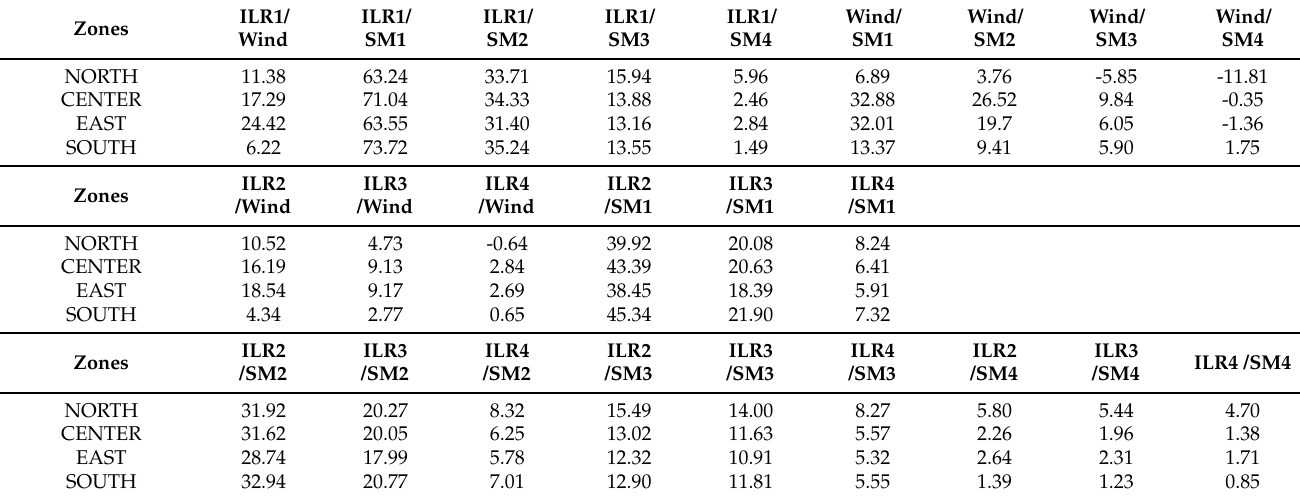
Table A3. Estimates of the covariances (10 − 10 ) between the predicted capacity factors and the inverse of the demand in the same region over the year 2018. ILR1 or SM1: without storage; ILR > 1 or SM > 1: with increasing levels of storage.